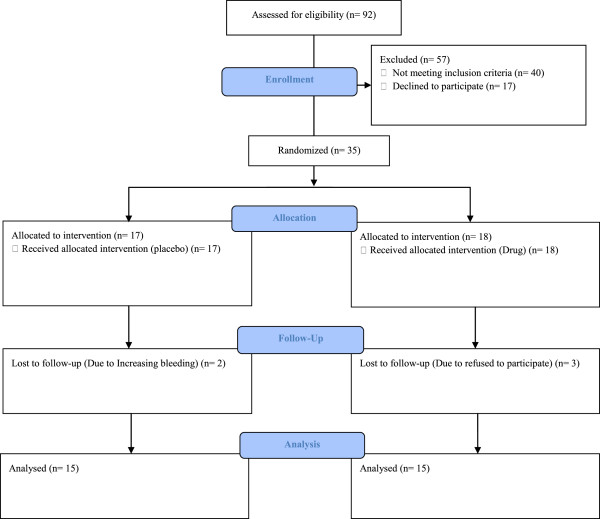
Study flow chart.